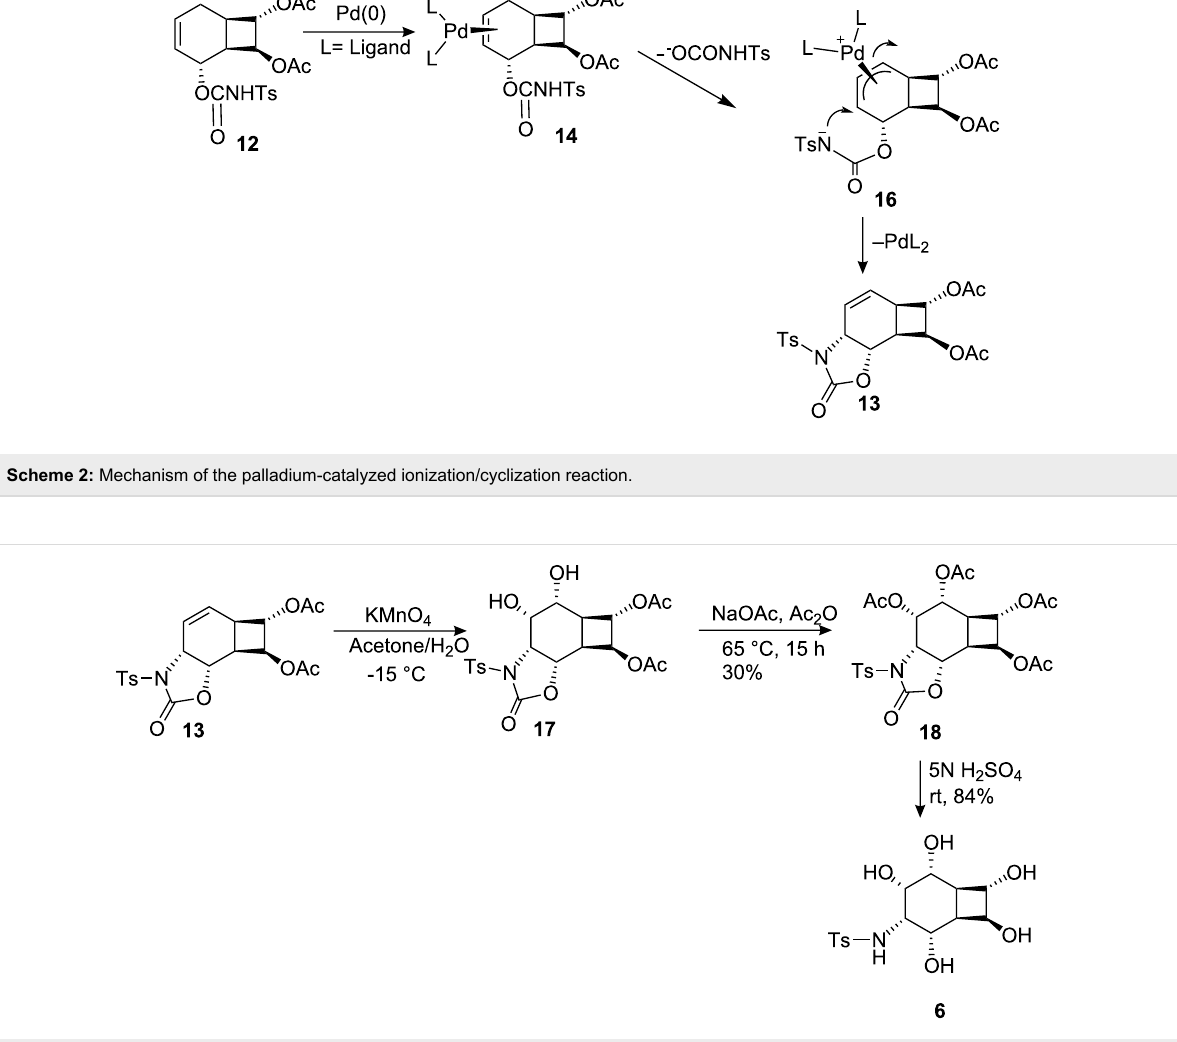
Scheme 3: Synthesis of aminocyclitol analogue 6